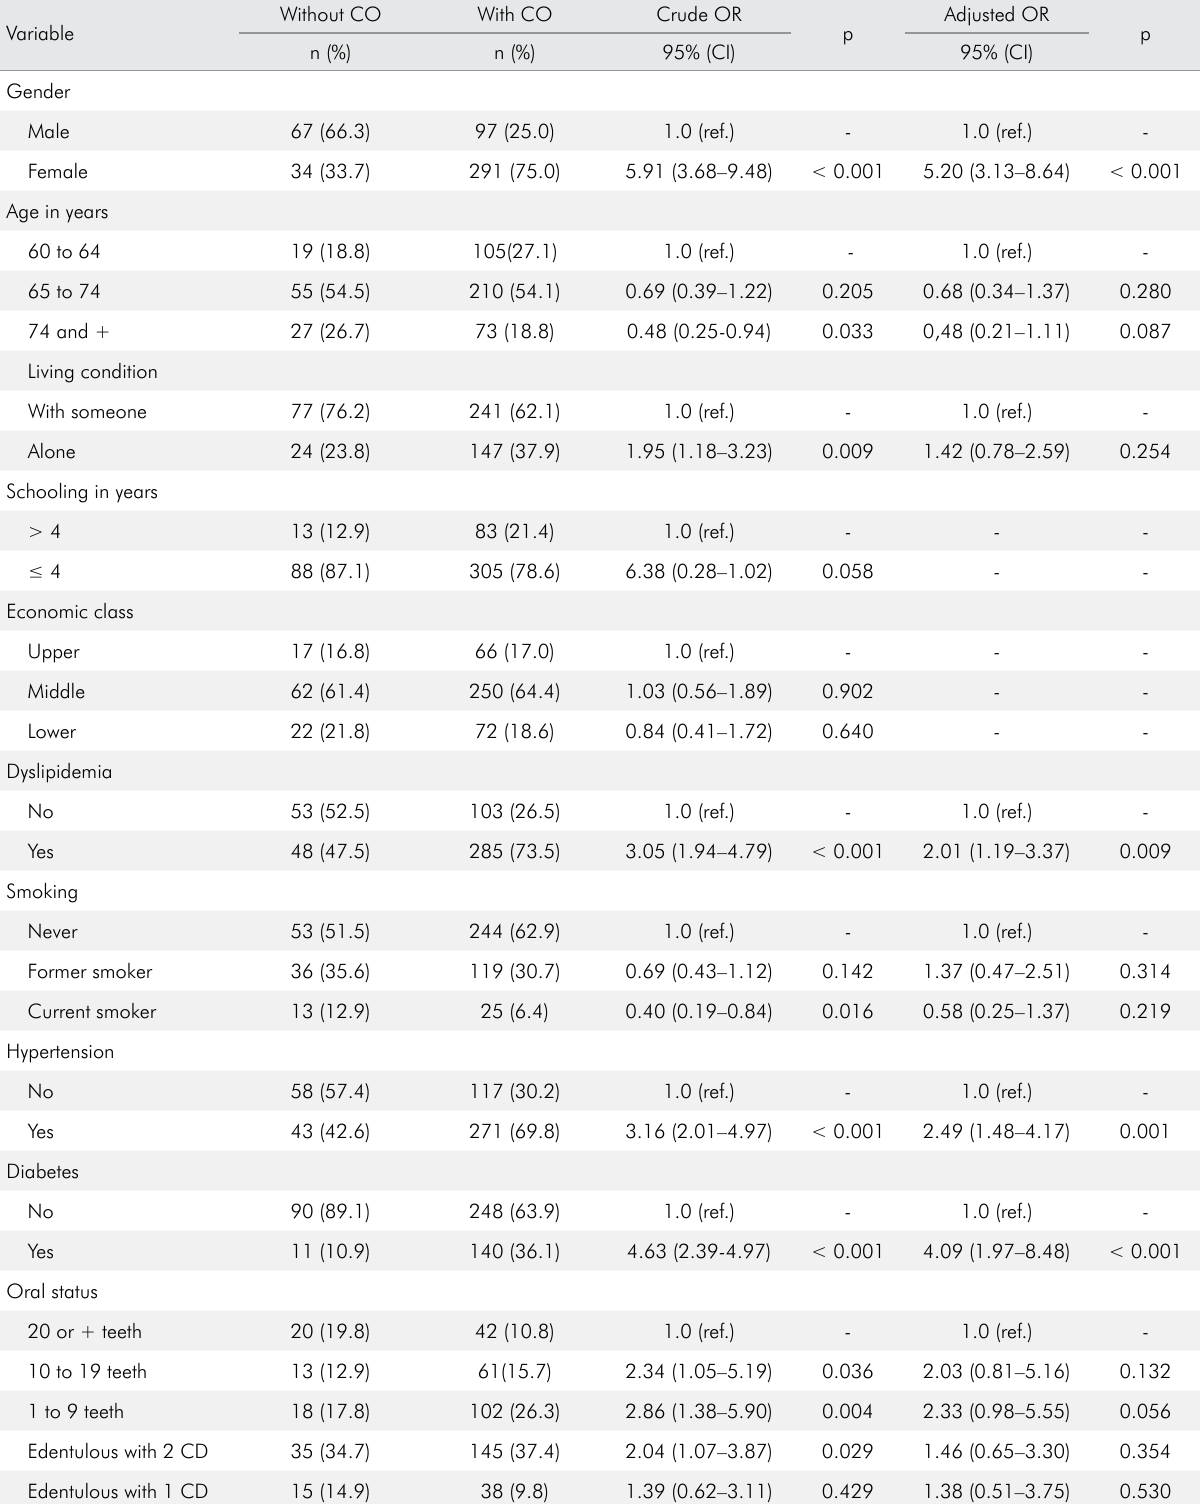
Table 1. Stepwise logistic regression between the independent variables and the presence of central obesity (CO), as established by the measure of waist circumference (WC) in the elderly (n =